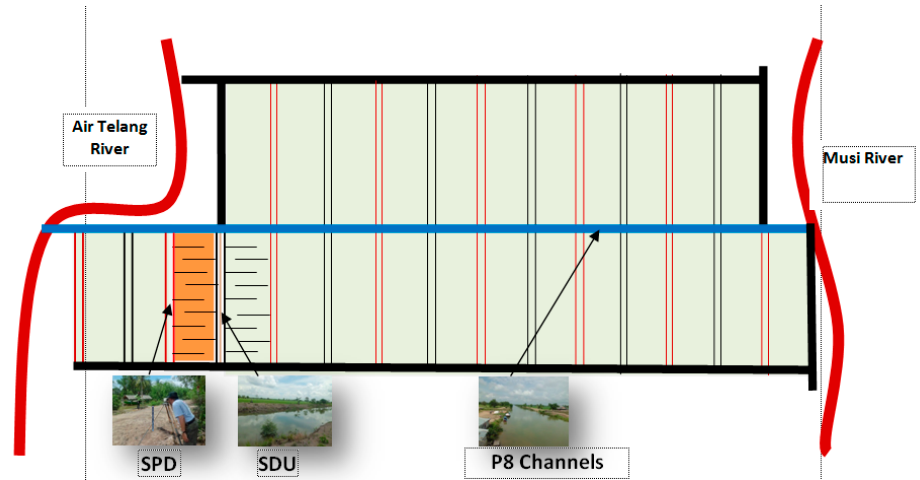
Figure 2. Schematic diagram of water system at P8 Telang I.